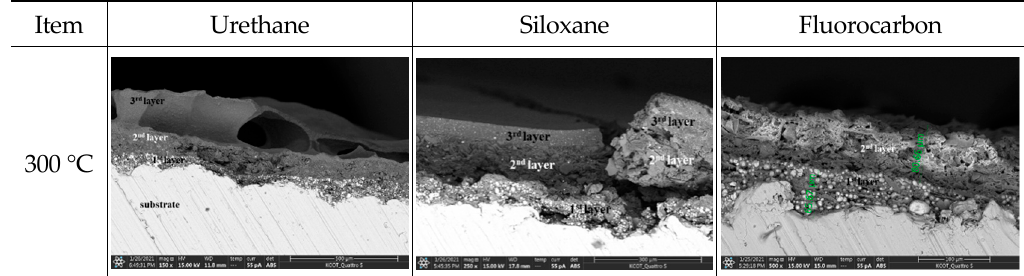
Figure 9. Magnified X-section conditions (~150–500×).